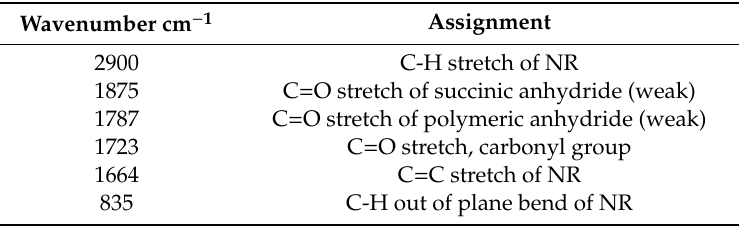
Table 2. The observed peaks and their assignments for MNR samples.